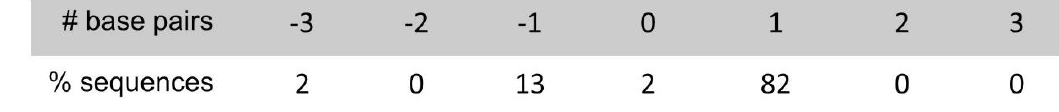
Figure 3. Overview of the lateral root-specific gene knockout system in Arabidopsis using p GATA23 -CRISPR-TSKO. ( A ) Schematic presentation of the specific expression of Cas9 translationally fused to the fluorescent reporter mCherry in lateral root founder cells by using the GATA23 promoter sequence (indicated in red). ( B ) Schematic presentation of the guide RNA (gRNA)–Cas9 complex. Cas9 is translationally fused to the fluorescent reporter mCherry (indicated in red). ( C ) Example of the mutation profile of a sampled lateral root of a seedling with the p GATA23 -CRISPR-TSKO construct. The frequency of different alleles of the targeted gene was determined by sanger sequencing and subsequent TIDE analysis [47]. One-base-pair insertions are the predominant outcome.